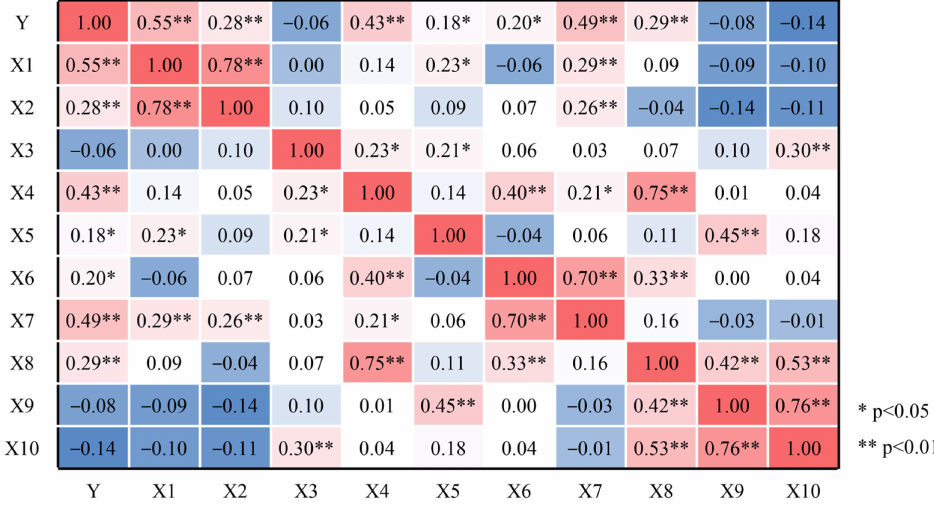
Figure 5. Correlation